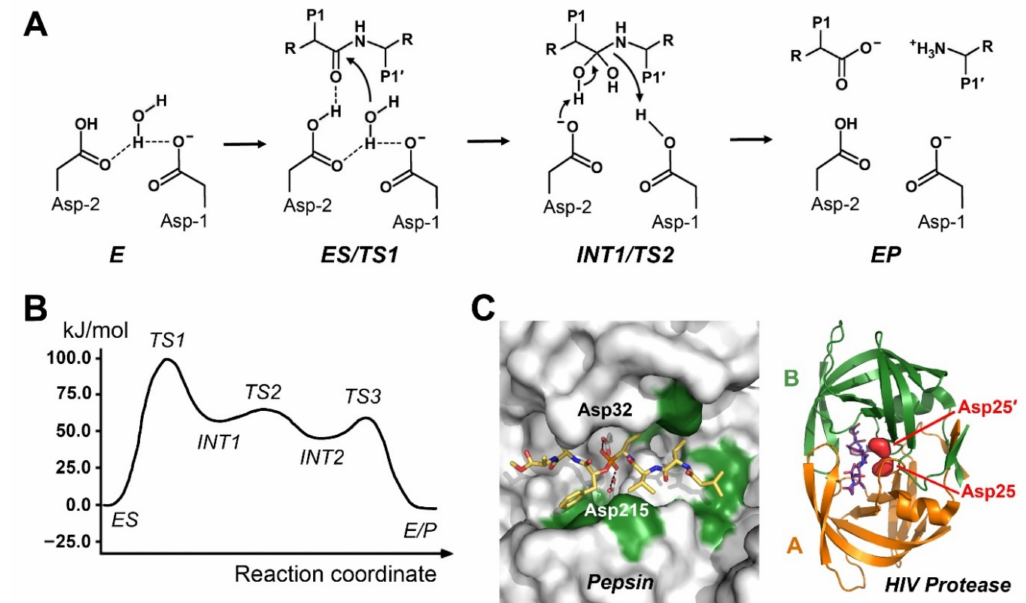
Figure 2. Mechanism of aspartic proteases. ( A ) Essentially three major steps takes place, including formation of the Michaelis complex 1. Nucleophilic attack by an activated water molecule with transition state 1 (TS1) and formation of a tetrahedral intermediate (INT). 2. Nitrogen conversion (TS2). 3. Fission of the scissile bond and release of the products with new C- and N-termini (EP). Residue numbering corresponds to pepsin. Two relevant aspartic proteases are shown in Figure 2C. ( B ) Free energy profile for the pepsin-like protease renin, with an additional reaction step including INT2 and TS3, according to Bras et al. (2012) [33]. ( C ) Left panel: Active site of pepsin with a phosphonate inhibitor, mimicking TS2 (PDB 1QRP). White areas are polar, green areas are hydrophobic. Right panel: The dimeric HIV protease has one catalytic Asp25 (red spheres) per monomer (PDB 4HVP). A peptidic inhibitor (purple sticks) is bound to the active site as ES